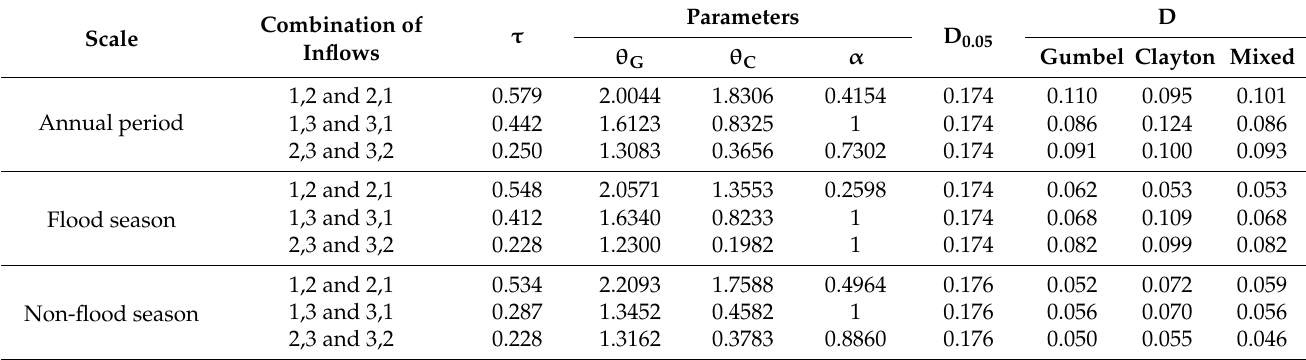
Table 5. The results of the parameter estimation and K-S tests of the binary copula functions between each two